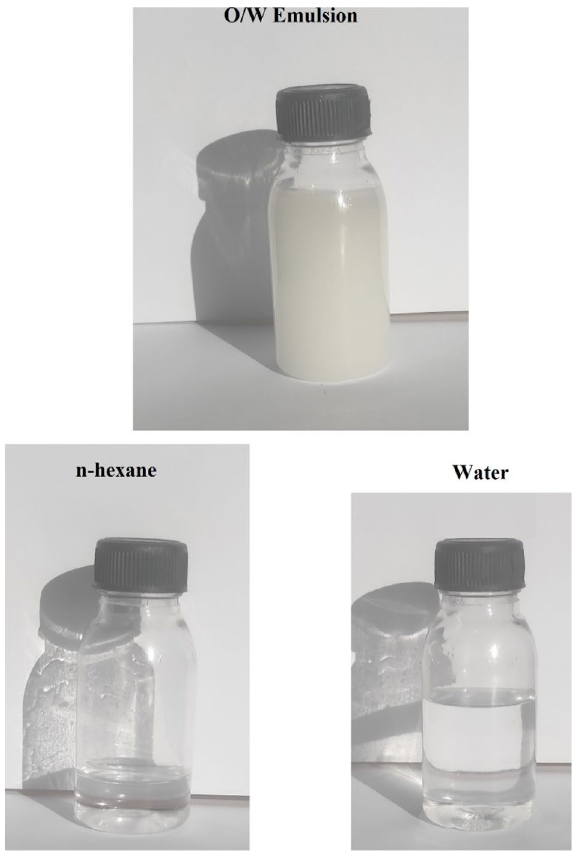
Figure 10. Images of oil-in-water emulsion before and after the separation process.